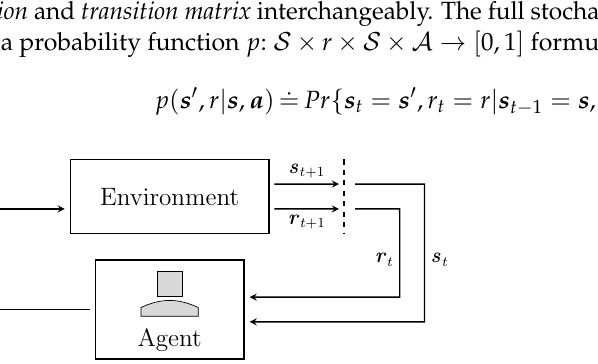
Figure 3. Schematic representation of the Markov decision process. Transitions are depicted in a discrete-time formulation to define variables at every time step. Each state is composed of a vector of observations or sensory inputs of the agent. The agent can choose an action from a given action-space at every step, which is evaluated through a reward